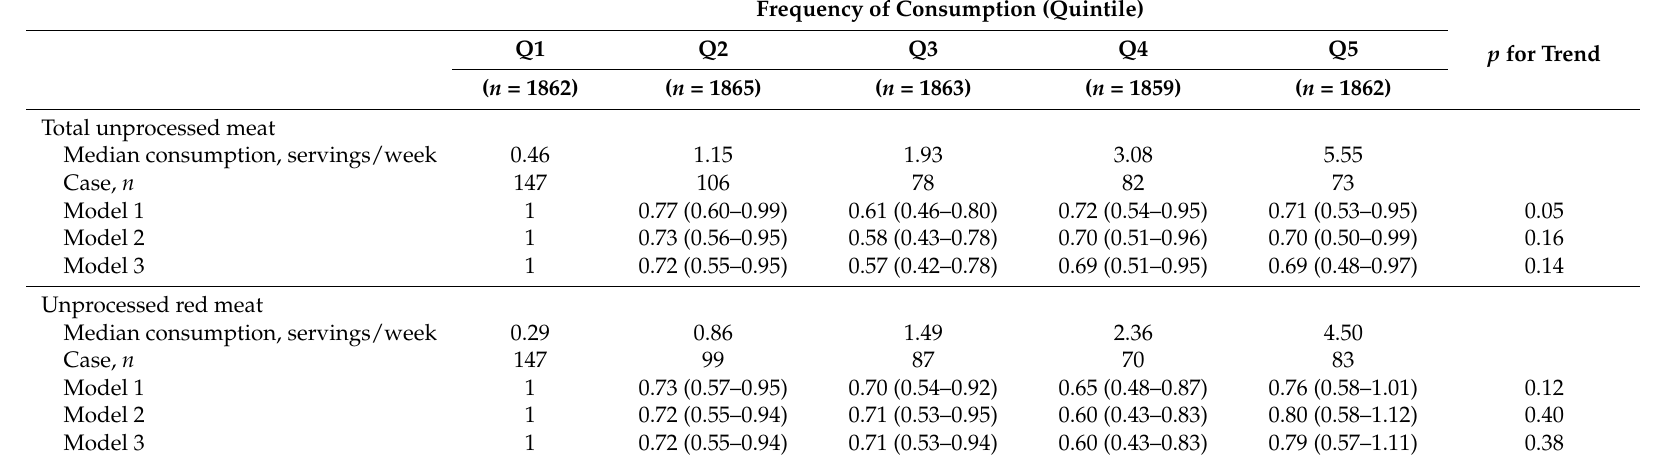
Table 2. Hazard ratios (95% confidence intervals) for cardiovascular disease (CVD) risk according to quintiles of consumption of total unprocessed meat and unprocessed red meat in Korean